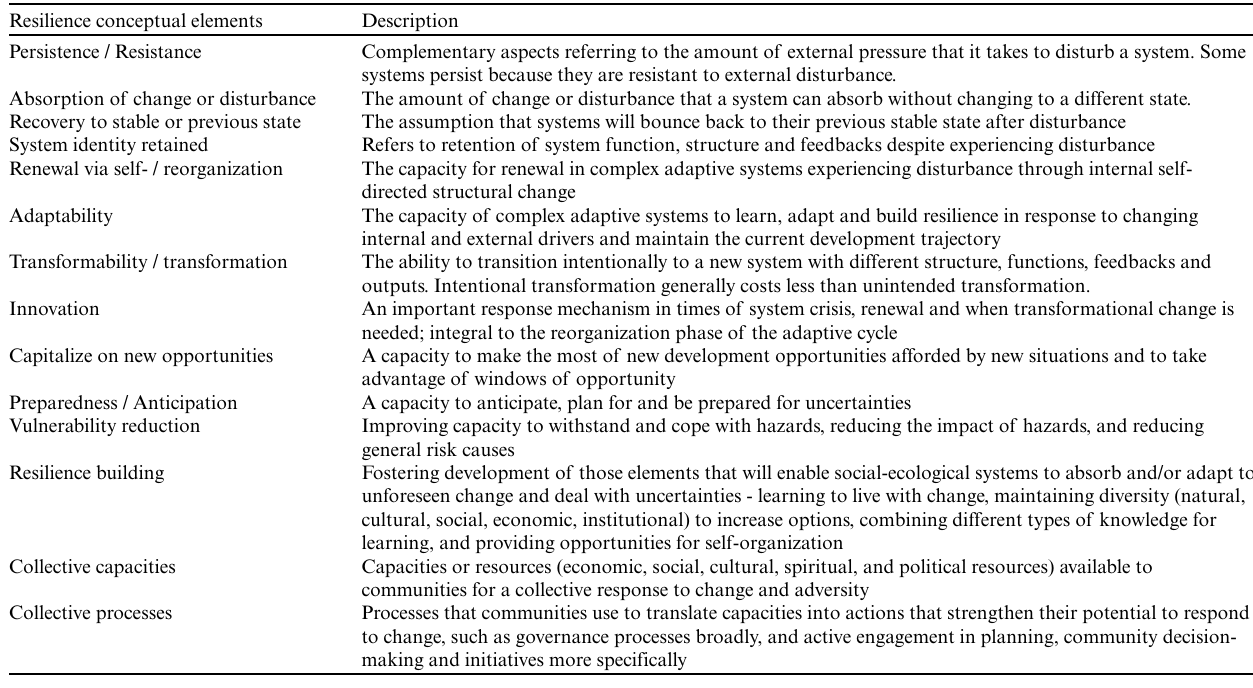
Table 2 . Resilience conceptual elements and their